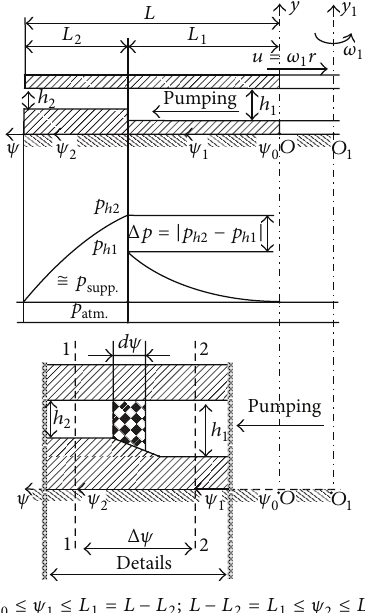
Figure 4: Radial step of the inner pumping bearing.